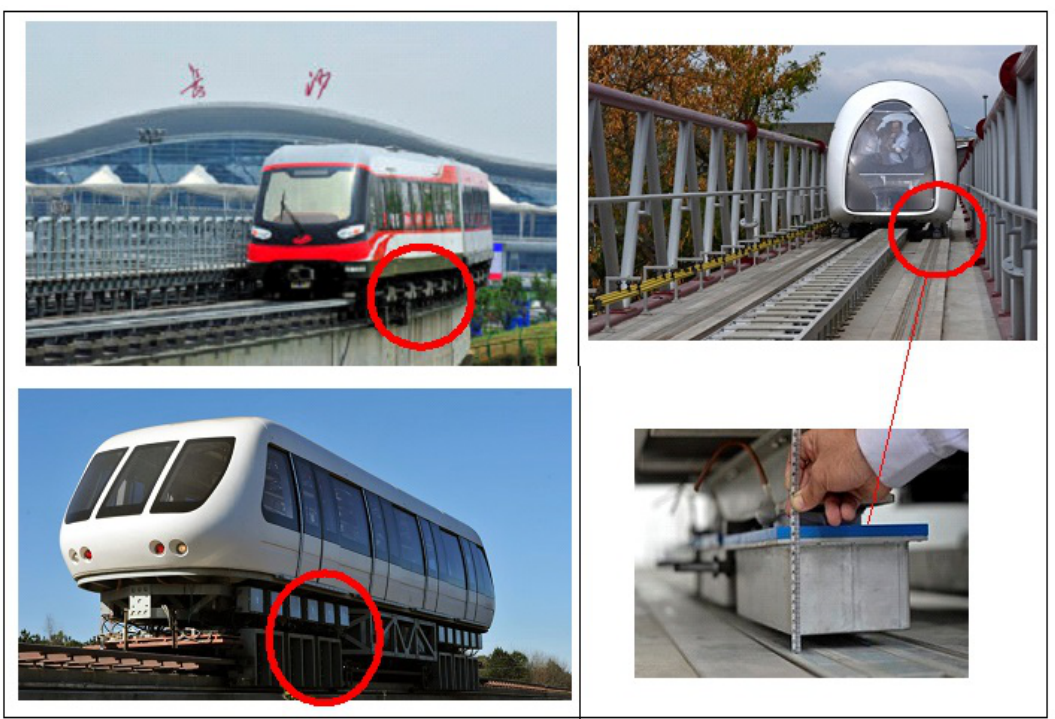
Figure 6. Comparison of the system required to obtain EML levitation (left side) with the cryostats required for MagLev 2 -Cobra, which employs SML technology (right side): simpler and more